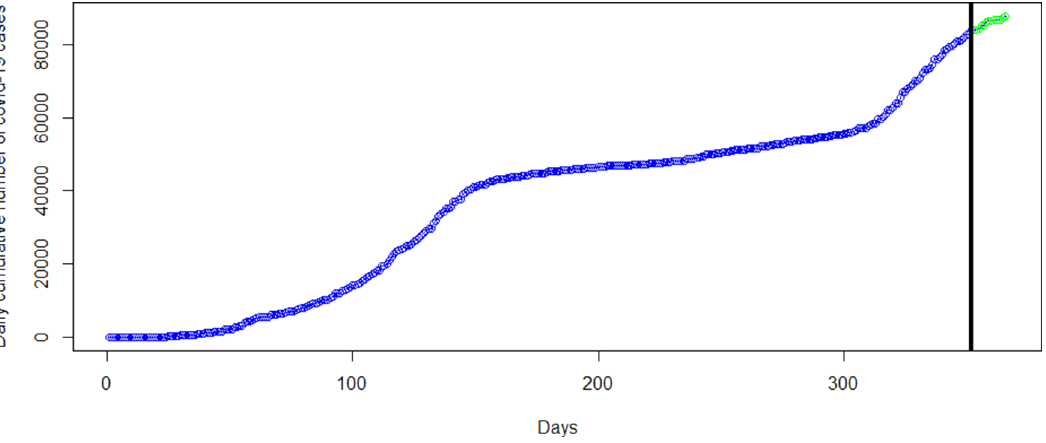
Figure7.ObservedCOVID-19datausedinanalysisfromMarch14,2020toFebruary28,2021(bluemarkerdots) with forecast data from day 1 to day 31 of March, 2021 (green marker dots).